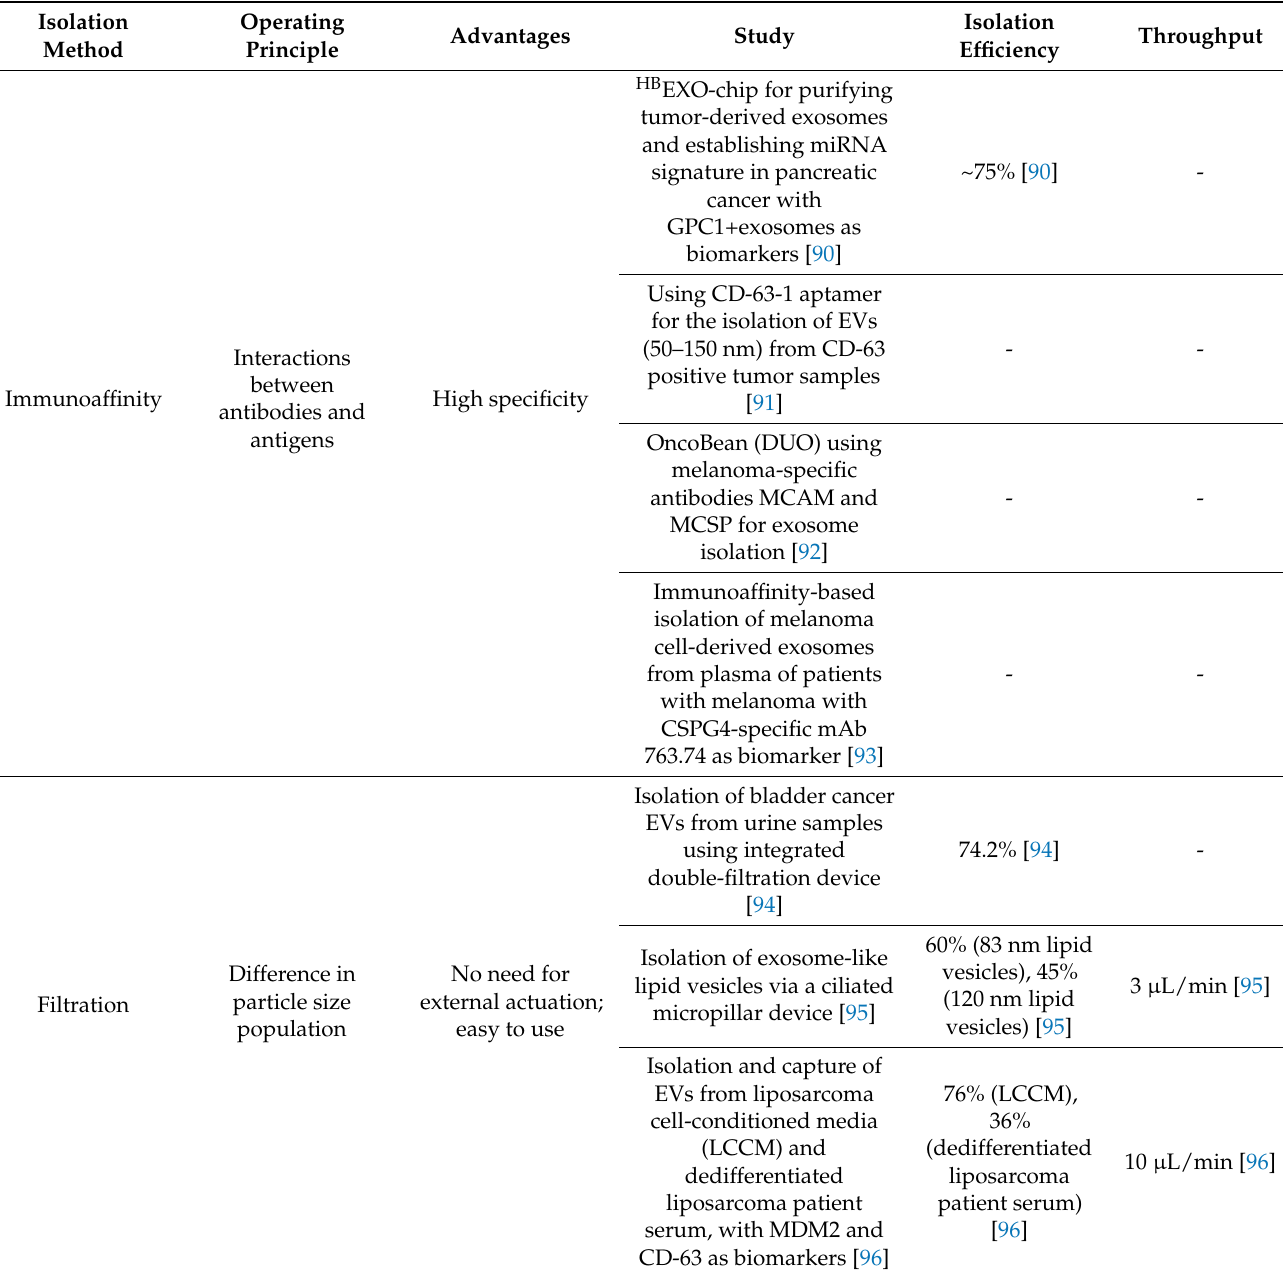
Table 2. Table summarizing several microfluidic techniques for isolation of